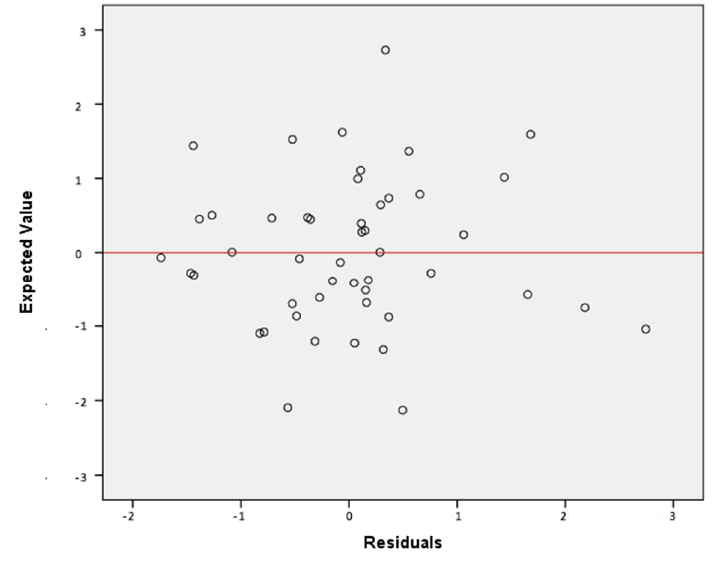
Figure 3. Scatter plot of residuals and expected values of GIN.